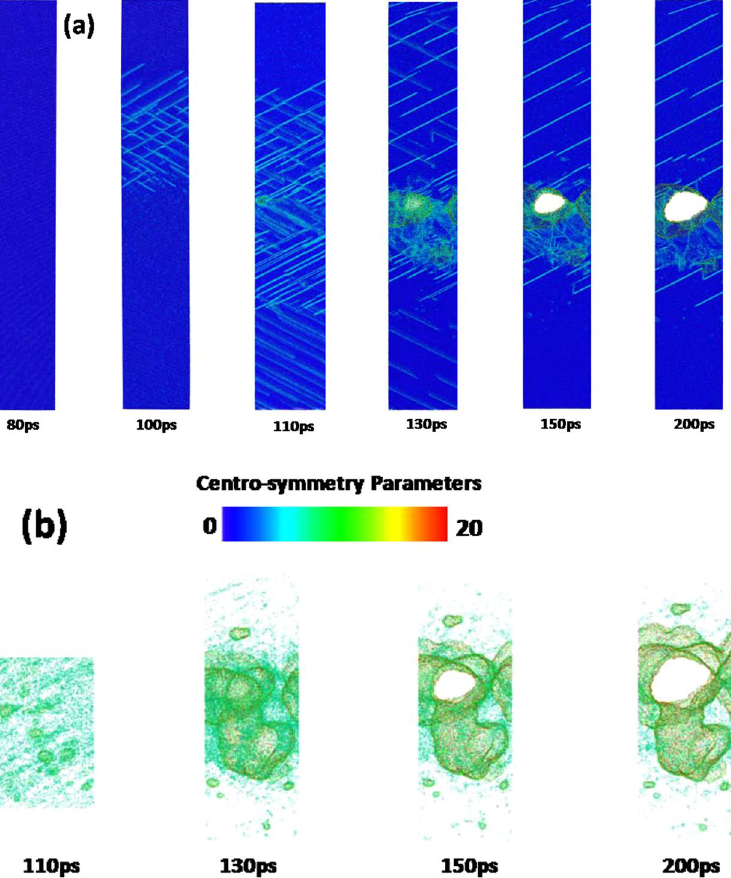
Figure 14. Snapshots of atomic centro-symmetry parameter in the 320–420 nm part of 450 nm 〈 110 〉 copper film under an absorbed laser intensity of 0.065 J/cm 2 at 80–150 ps time instant. The atoms are colored according to their centro-symmetry parameters, ( a ) 0 < CSP < 20, (b) CSP >